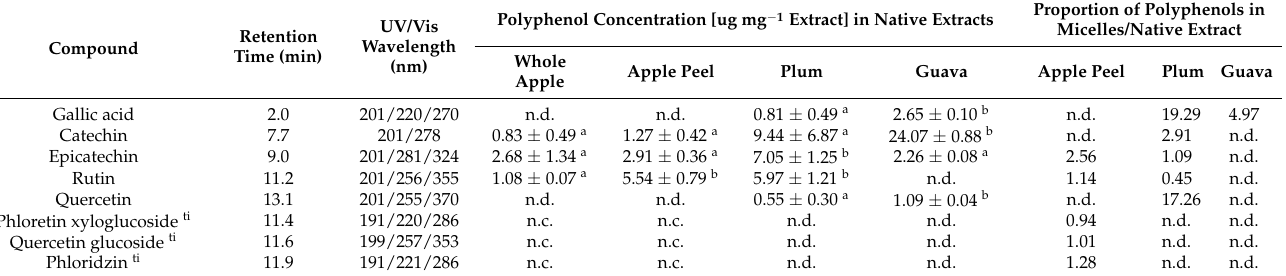
Table 2. Specific polyphenols (mean ± SD; n = 3) detected and quantified by HPLC-DAD in water– ethanol extracts (native powder and their micellarized formulations) of apple ( M. domestica cv. Anna), plum ( P. domestica cv. Satsuma), and guava ( P. guajava L.) fruits.